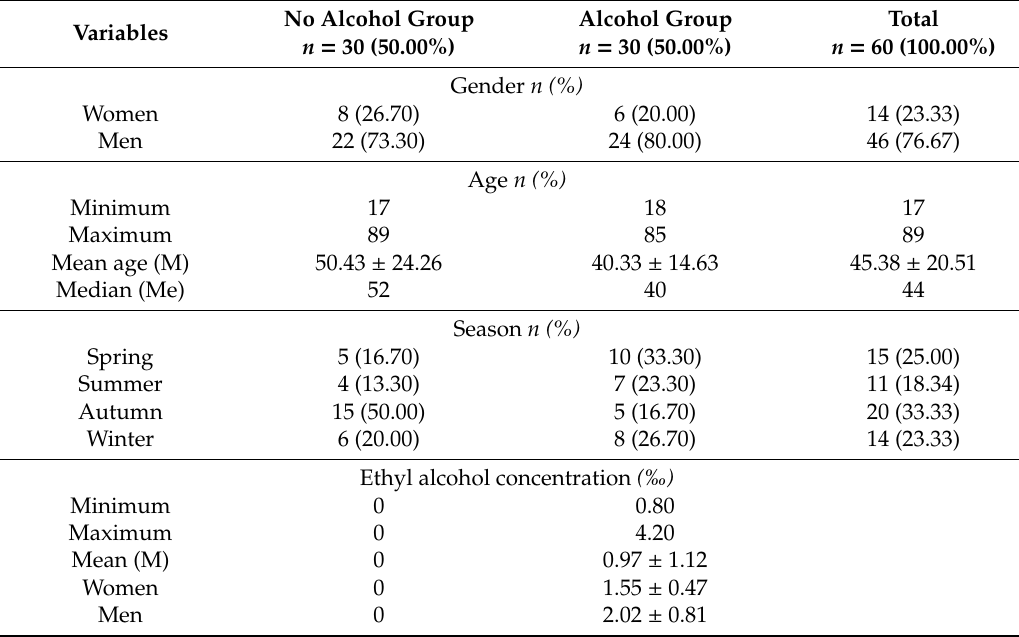
Table 1. Characteristics of railway suicide